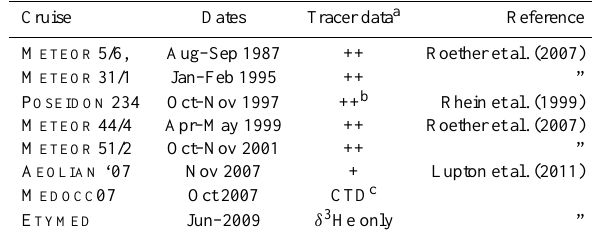
Table 1. The cruises providing